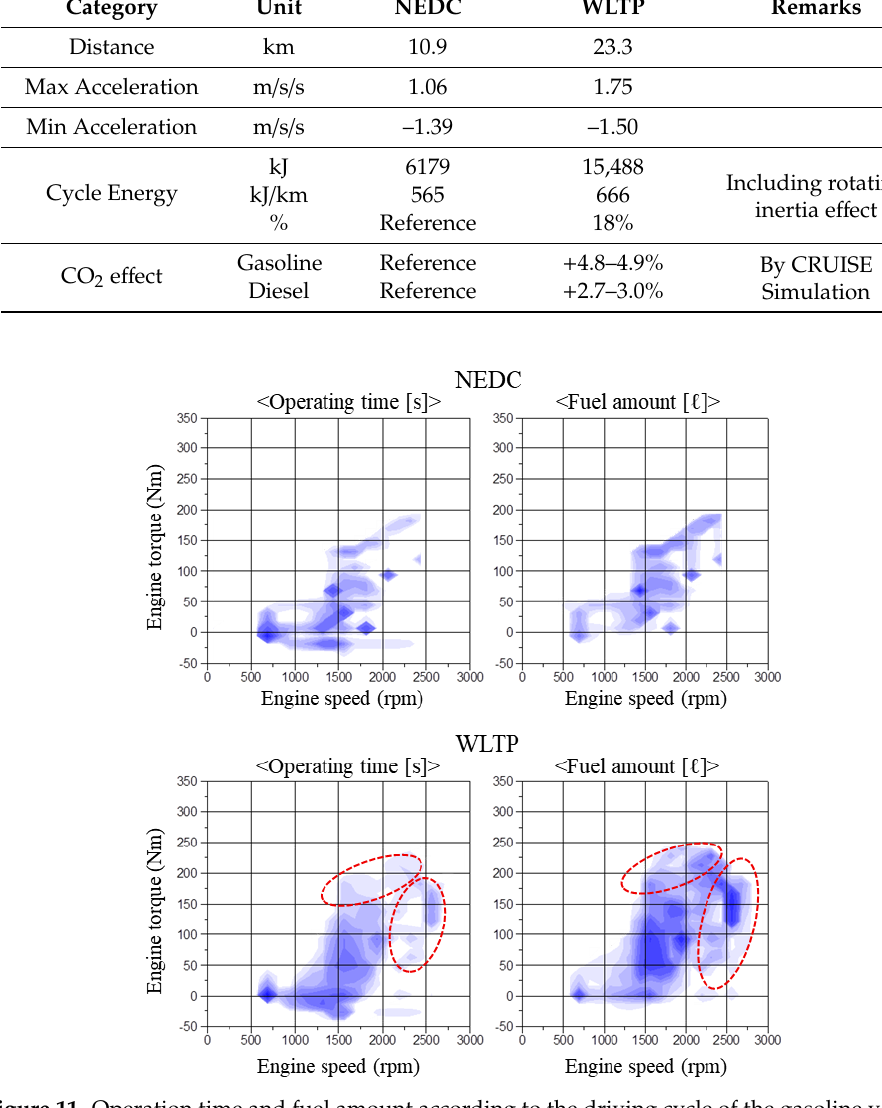
Table 6. Cycle energy and CO 2 e ff ect by simulation according to the test mode (per test mass of 1718